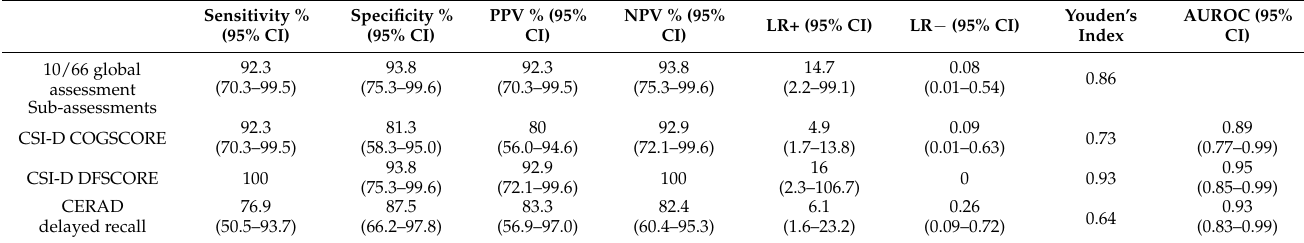
Table 5. Psychometric properties of 10/66 dementia protocol and its